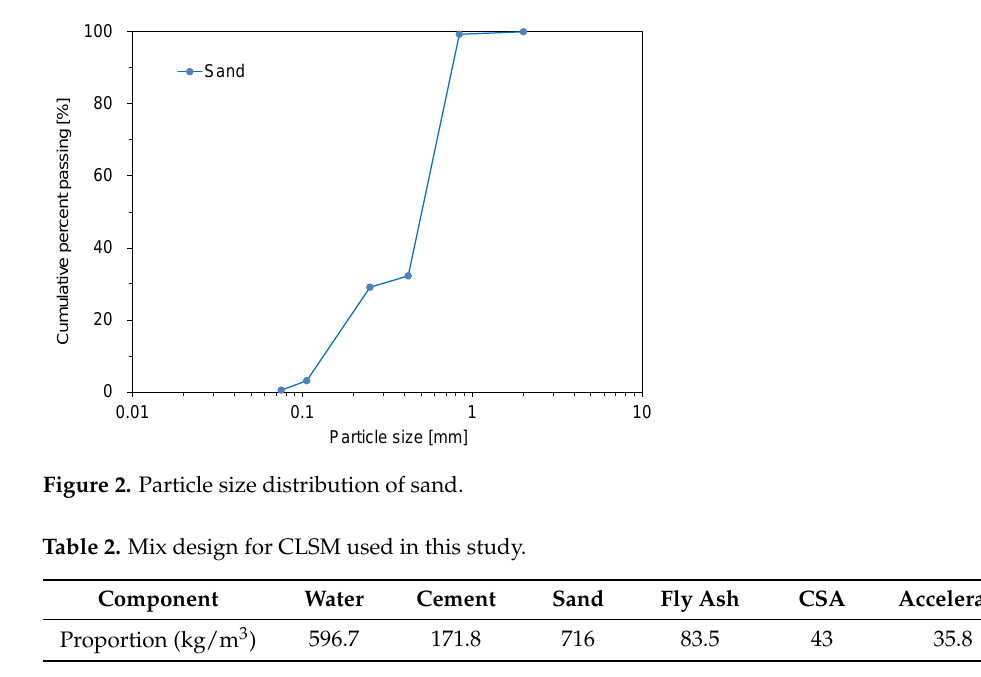
Table 3. Air contents and unit weights of the CLSM mixtures with six different fly ashes.